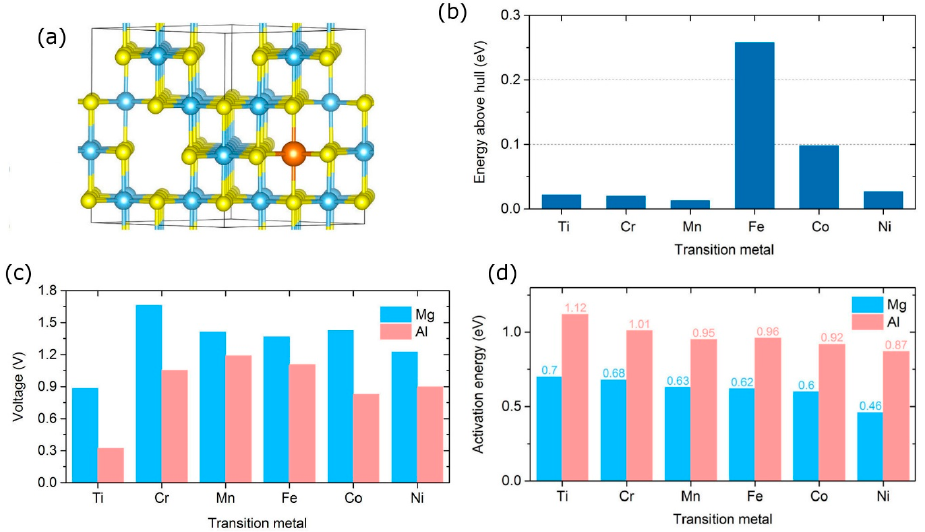
Figure 12. Electrochemical insertion in spinel sulfides: ( a ) Crystal structure with one inserted Mg/Al atom, where the transition metal, S and Mg/Al atoms are shown in blue, yellow and orange colors, respectively. Mg either occupies octahedral or tetrahedral sites, depending on the spinel, while Al has a strong preference towards tetrahedral sites in all investigated compounds; ( b ) Energy above hull for pristine compounds; ( c ) average insertion voltage, and ( d ) activation energy for Mg and Al diffusion. Reproduced from [35] by permission of the PCCP Owner Societies, © (2017) Royal Society of Chemistry.